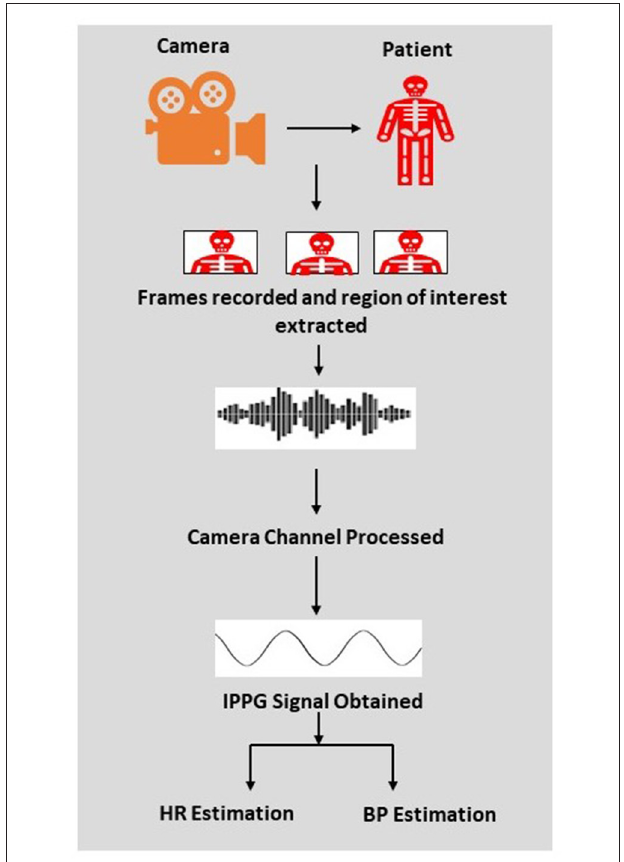
FIGURE 3 | Schematic of iPPG extraction.